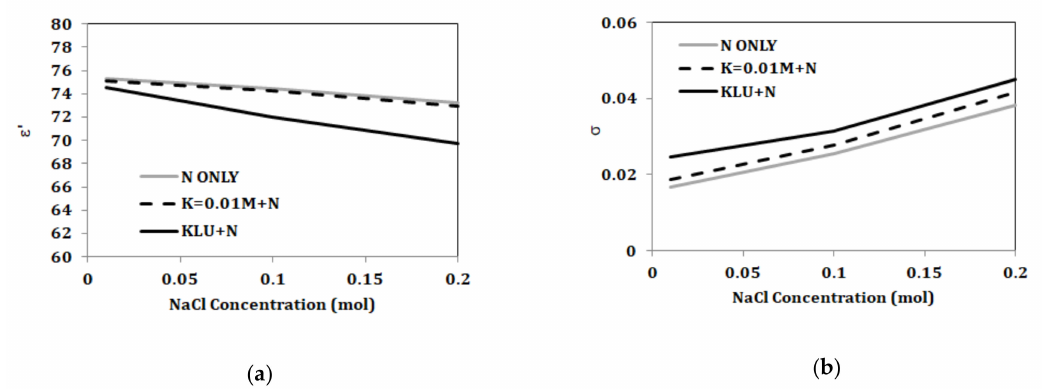
Figure 12. Measured ( a ) real part of complex permittivity ( ε ’) and ( b ) conductivity versus concentration at 2.45 GHz for aqueous solutions of NaCl, NaCl with K = 0.013 mol / L, NaCl with K = 0.01 mol / L, L = 0.02 mol / L, and U = 0.01 mol / L (“M” refers to mol / L).